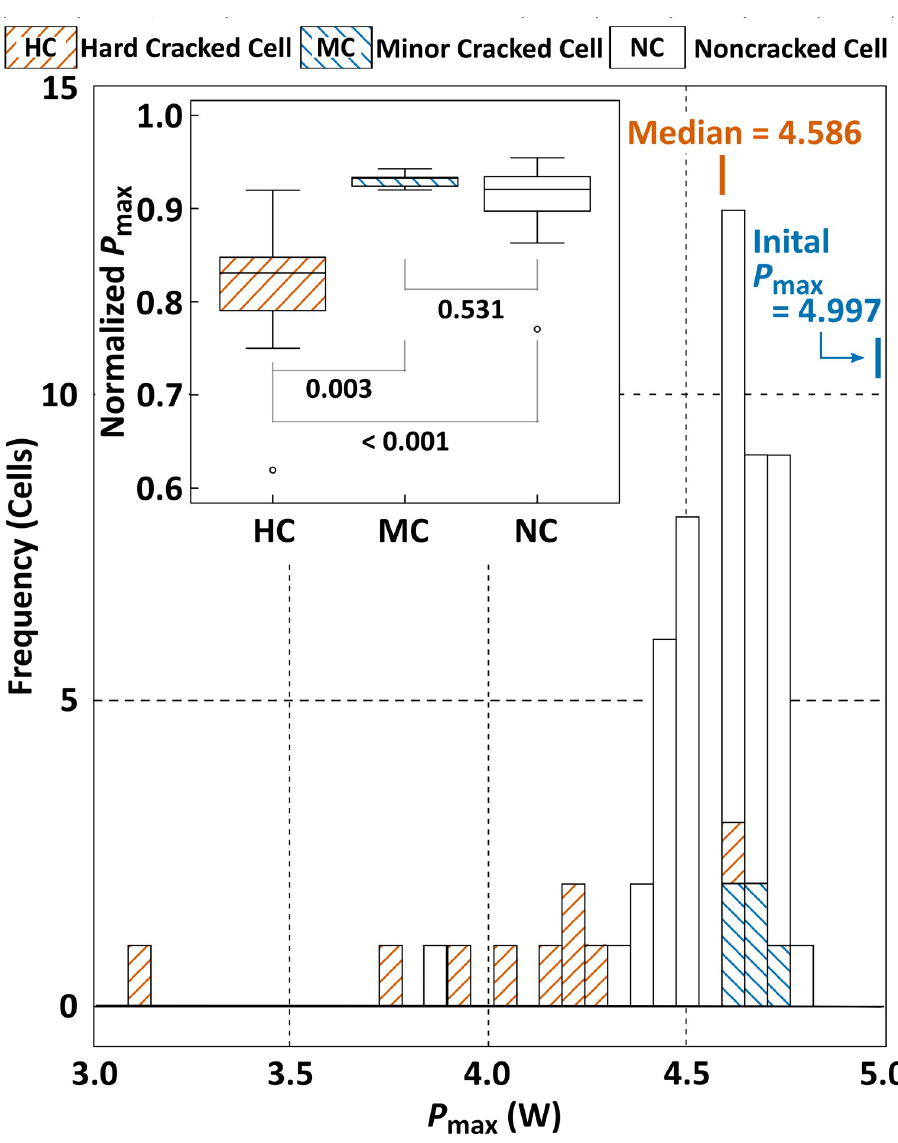
Fig 4. Histogram of P max for the individual PV cells within the evaluated PV module. The crack-class (HC-, MC-, or NC-cell) rated for the respective PV cells is indicated by the top legend. The distributions of the normalized P max are denoted as box-and-whisker plots, in a multicomparison chart for the categorized PV cells (inset). The open circles express outliers, and the figures shown in the inset chart represent the respective p -values in the multicomparison.